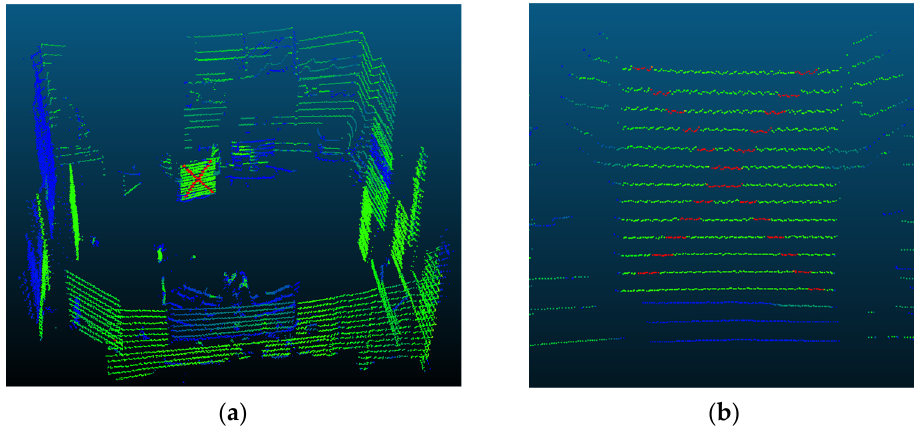
Figure 3. Pseudocolor representation of the laser beam return (intensity value) for a scan generated during the calibration process. ( a ) Overall view of the room. ( b ) View of the calibration target with the two distinct reflective stripes.